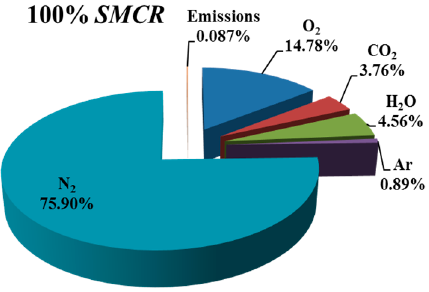
Figure 9. Exhaust gas composition of the 6S70MC MAN B&W low speed two stroke engine. Table 9. Exhaust gas composition at various main engine loads.